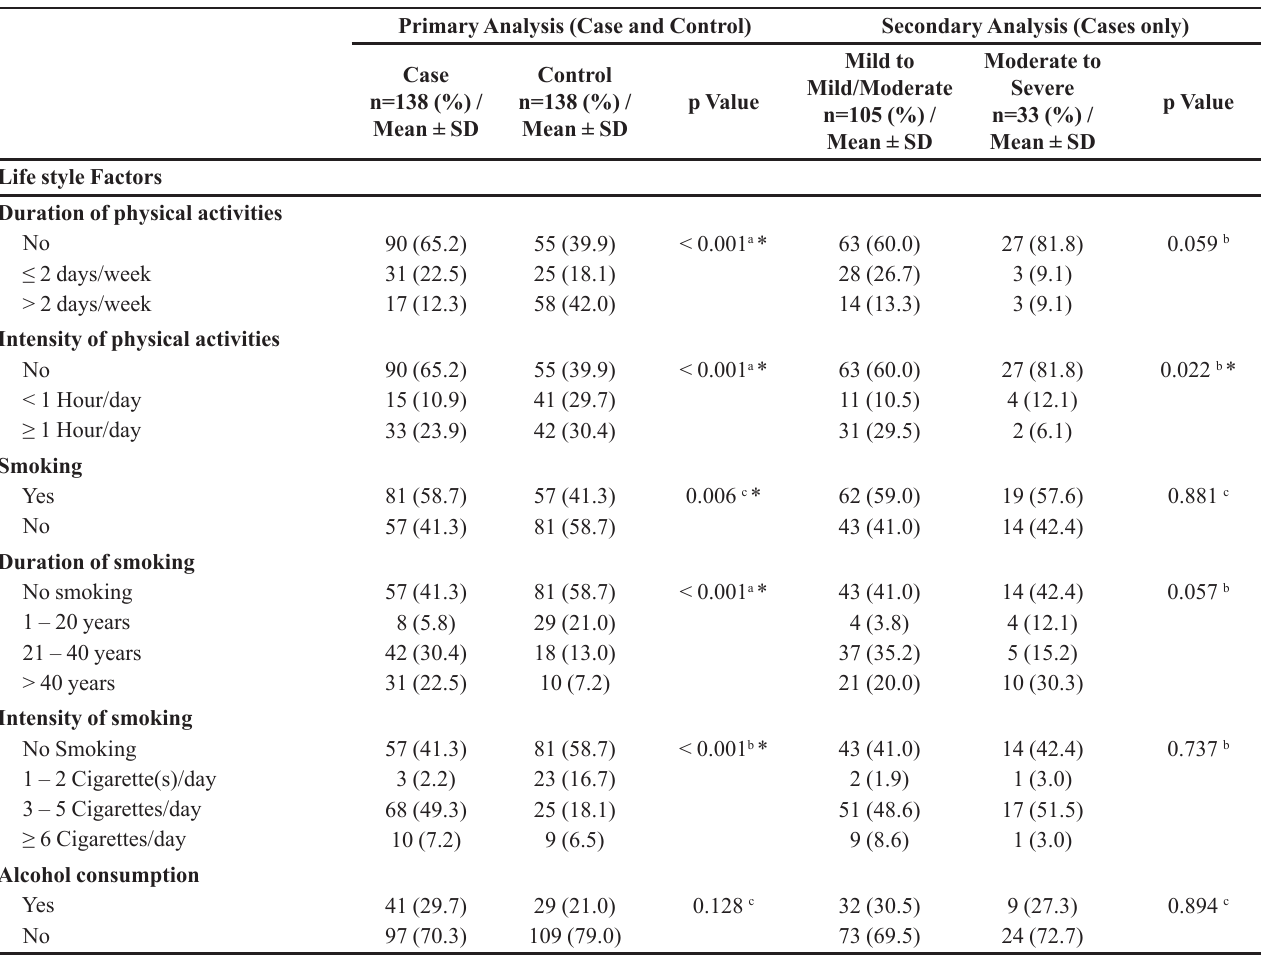
TABLE I - Association of Demographic, Clinical, Biomarkers and Lifestyle factors with Erectile Dysfunction and Severity of ED (cont.)